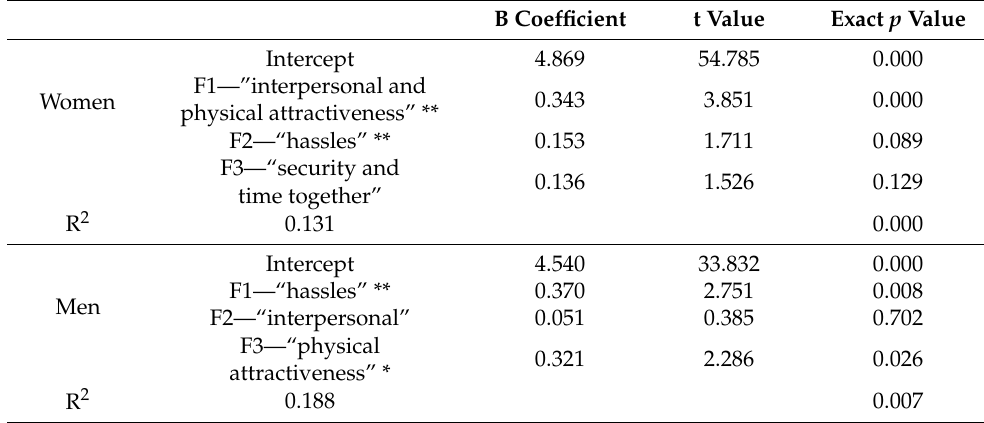
Table 3. Regression estimates predicting women’s sexual desire by factors by gender,